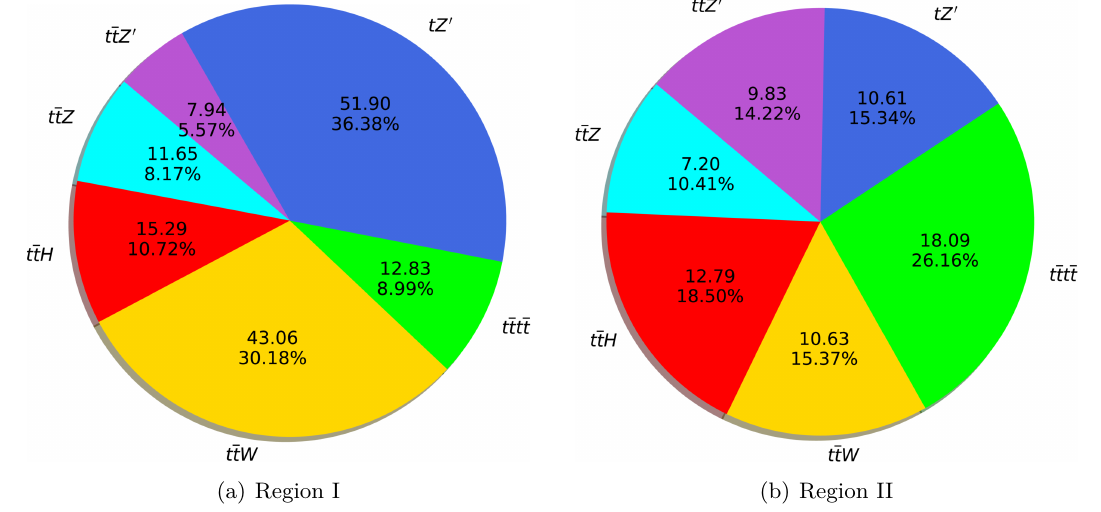
Figure 11 . Event yields and composition of Regions I and